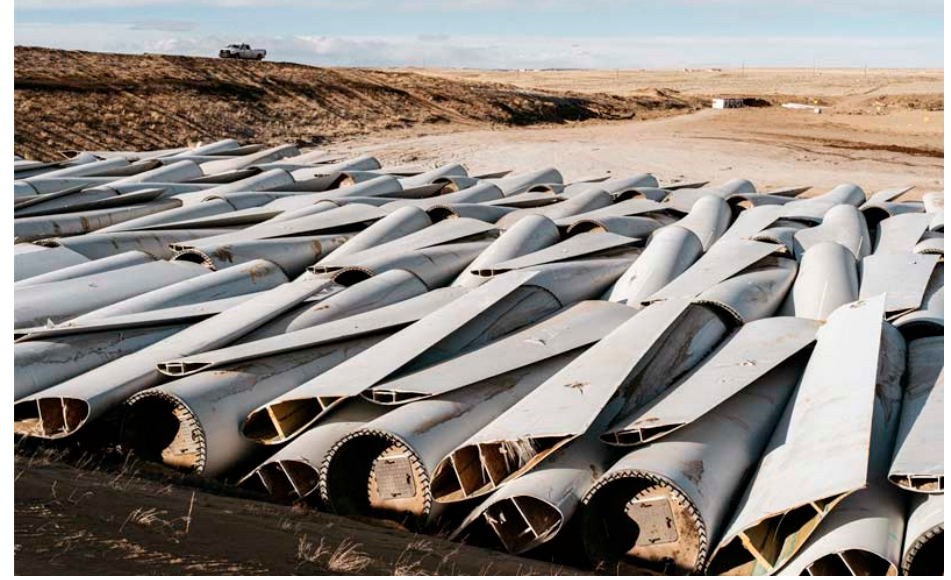
Figure 1. Wind turbine blades in a landfill (adapted from [22]).